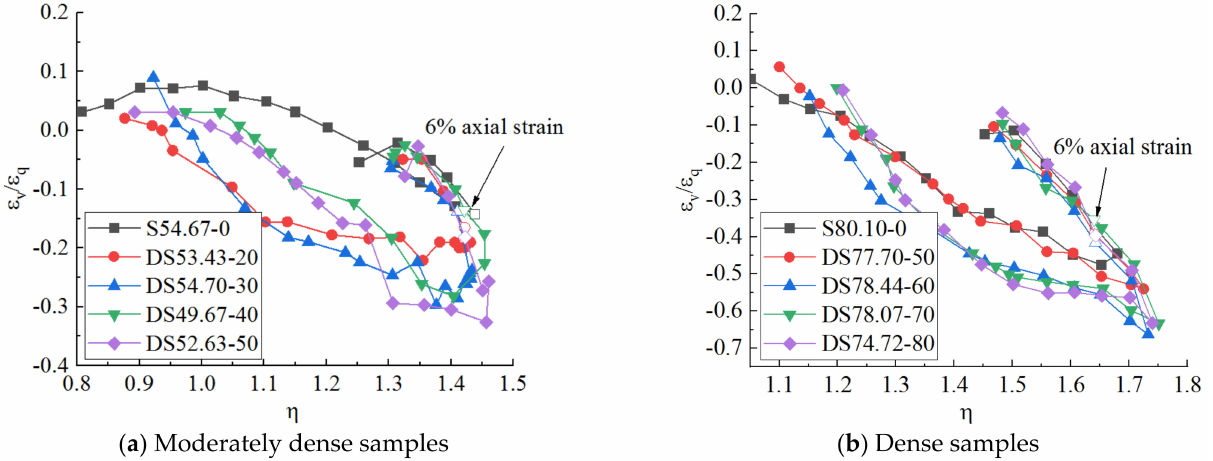
Figure 10. Stress–dilatancy response of the monotonic